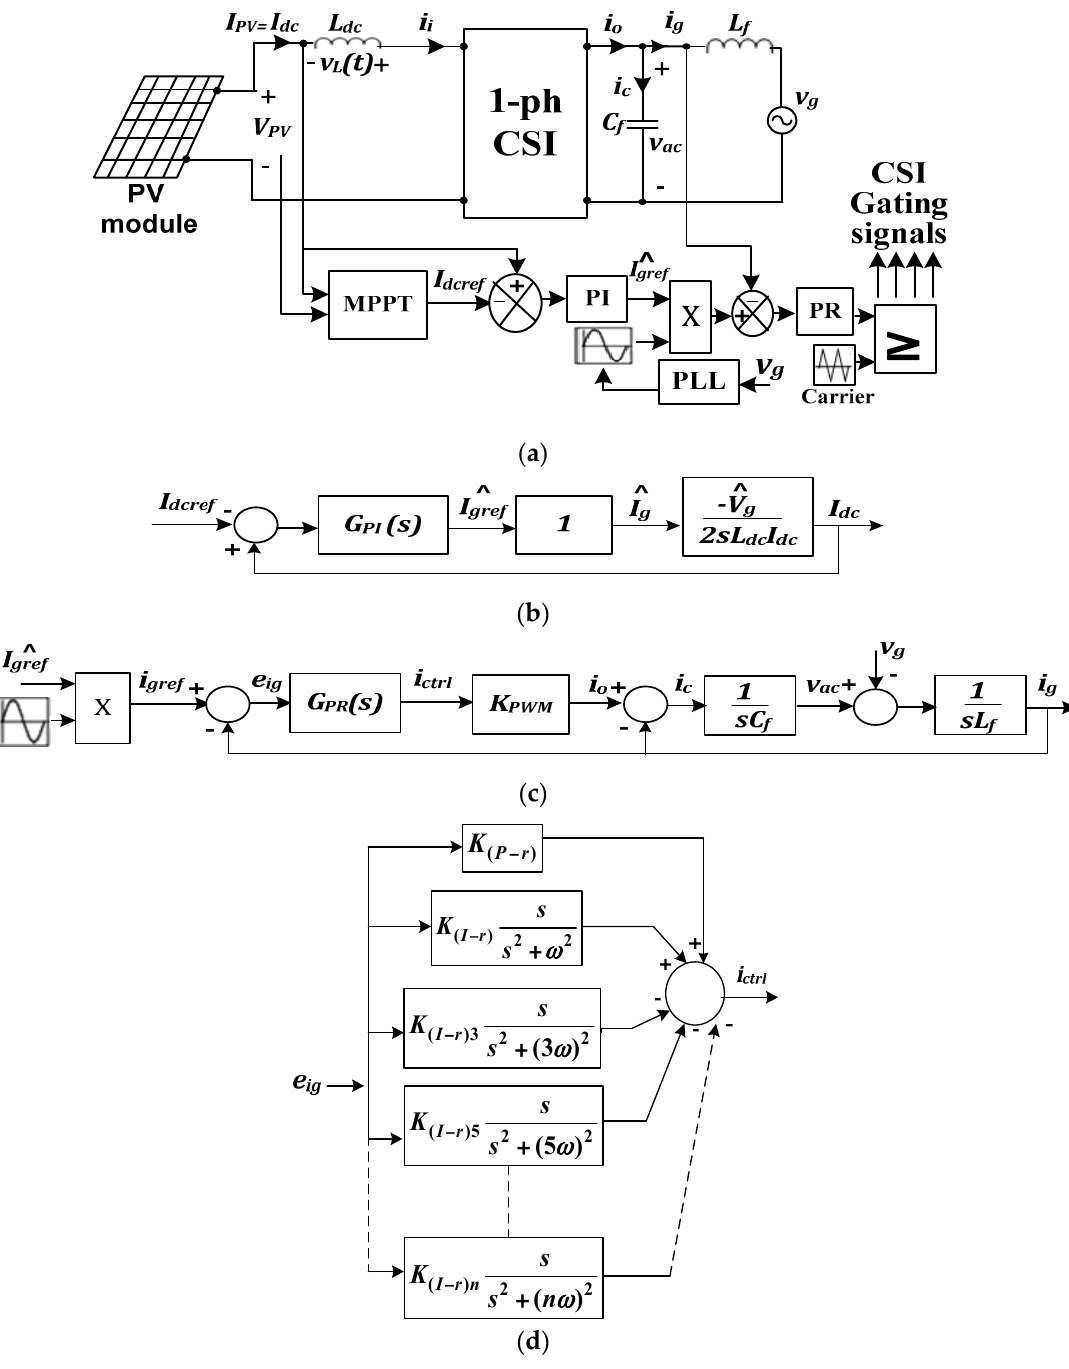
Figure 2. Control scheme for the proposed single-phase single-stage photovoltaic (PV) CSI system: ( a ) schematic diagram, ( b ) outer DC-link control loop, ( c ) inner grid current loop, and ( d ) proposed cascaded harmonic cancellation.